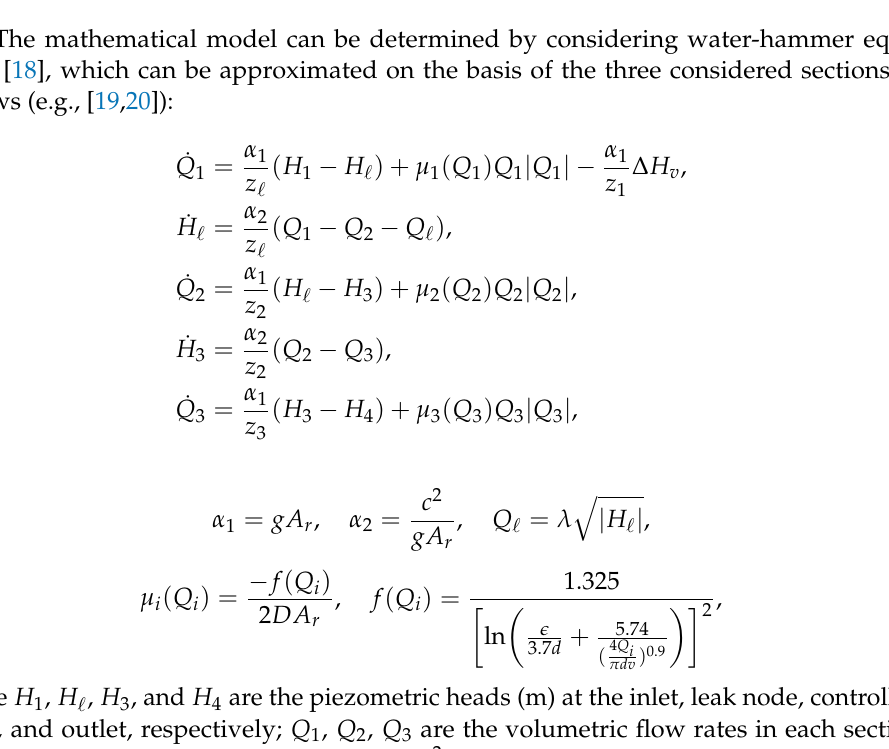
Figure 1. Case 1: Pipeline with a leak before the controlled